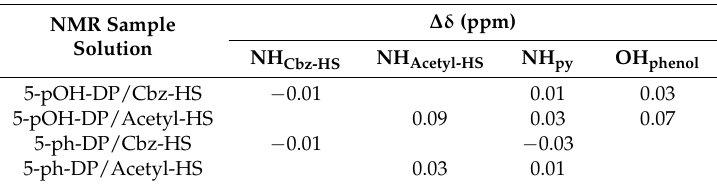
Table 1. Chemical shift changes of the NMR solution of monomers and HS-derivatives with respect to their free form.